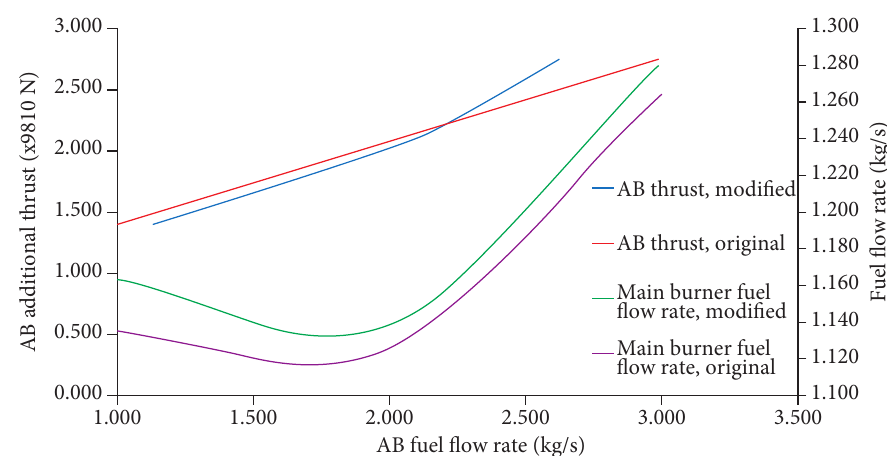
Figure 17. Thrust and main burner fuel flow rate variation with AB fuel flow rate when default and modified area schedules are